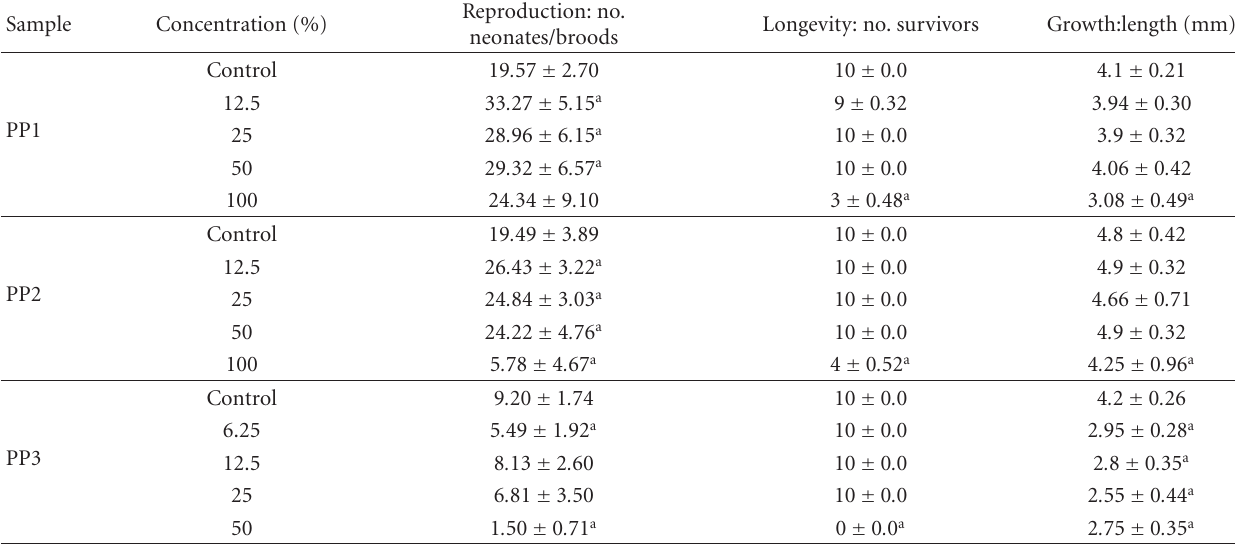
Table 5: E ff ects on reproduction, longevity, and growth of Daphnia magna exposed to soluble fractions of pulp and paper mill waste, samples PP1, PP2, and PP3, during 21 days. Results are expressed as means ± standard deviation.